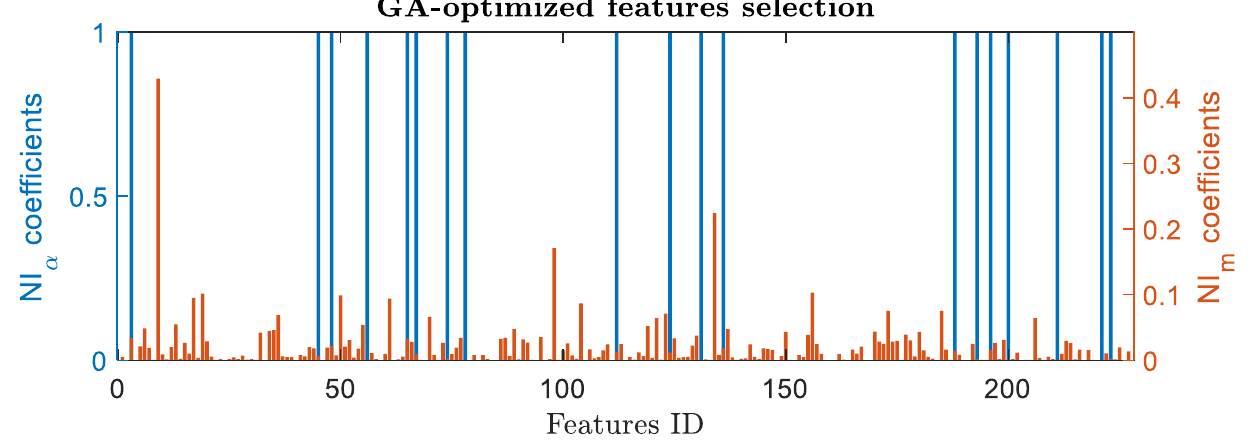
Figure A1. Coefficient values obtained thanks to GA optimization for the calculation of NI α (in blue) and NI m (in red).